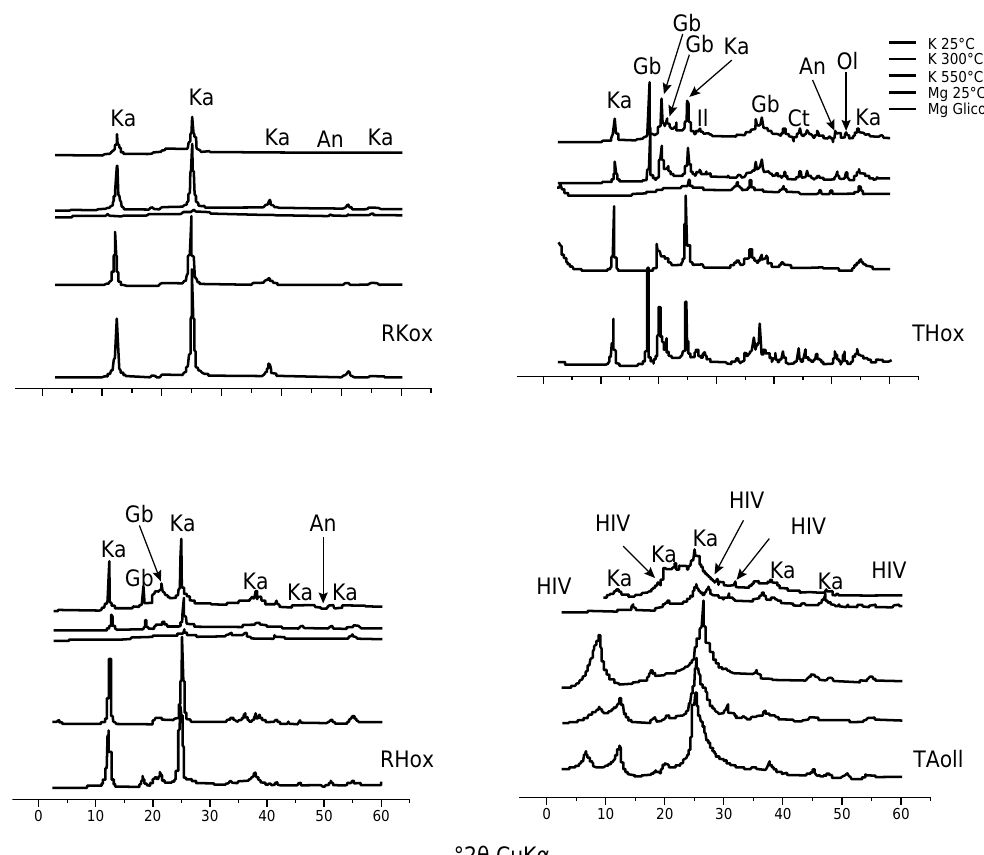
Figure 2. X ray diffraction patterns for clay fractions from the soil diagnostic horizons. Ka: kaolinite; Gb: gibbsite; Ct: chlorite; An: anatase; and HIV: hydroxy-interlayered